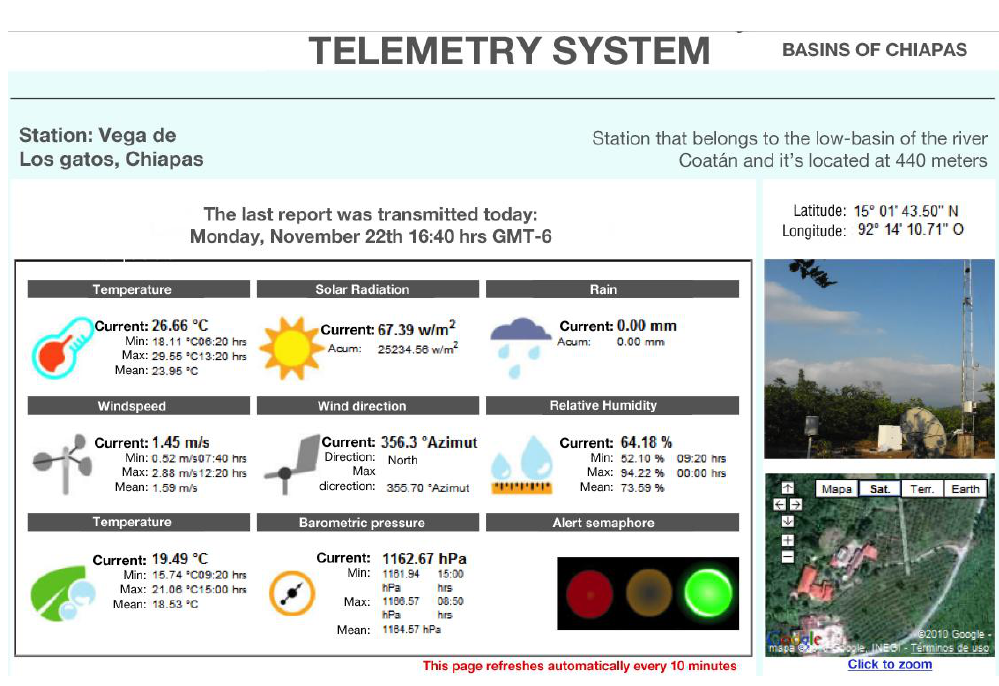
Figure 16. Numerical interface oriented to the final user.